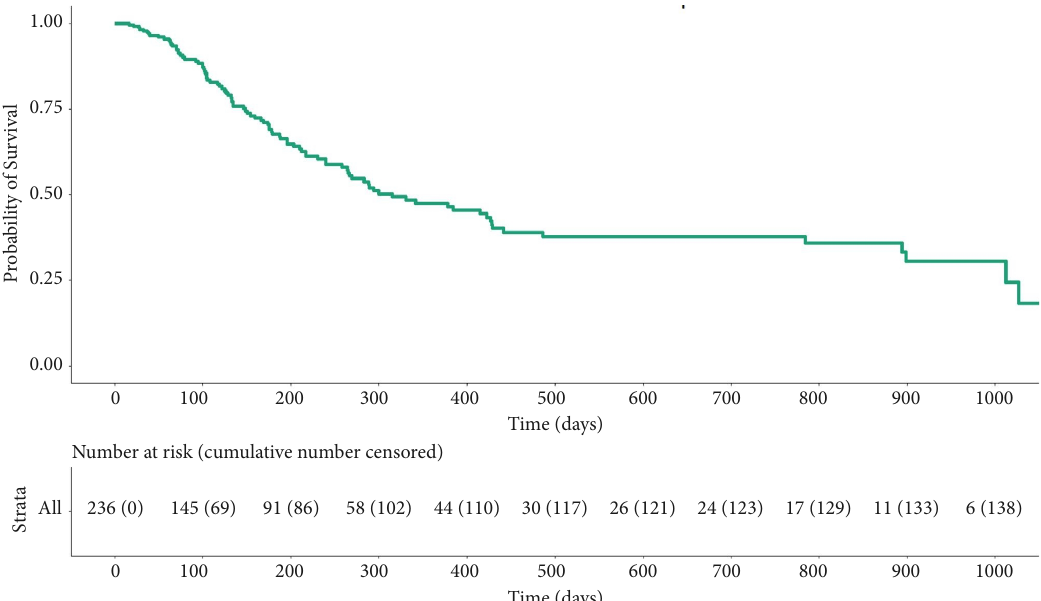
Figure 4: Kaplan–Meier analysis demonstrating a failure to preserve > 20% IOP reduction from baseline for two consecutive visits over time in